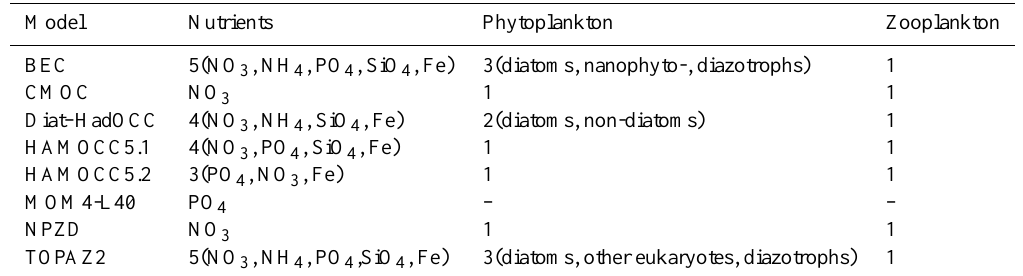
Table 2. Main characteristics of the marine biogeochemical components of the nine ESMs used in this study: list of nutrients limiting the phytoplankton growth and the number of explicitly represented phytoplankton and zooplankton